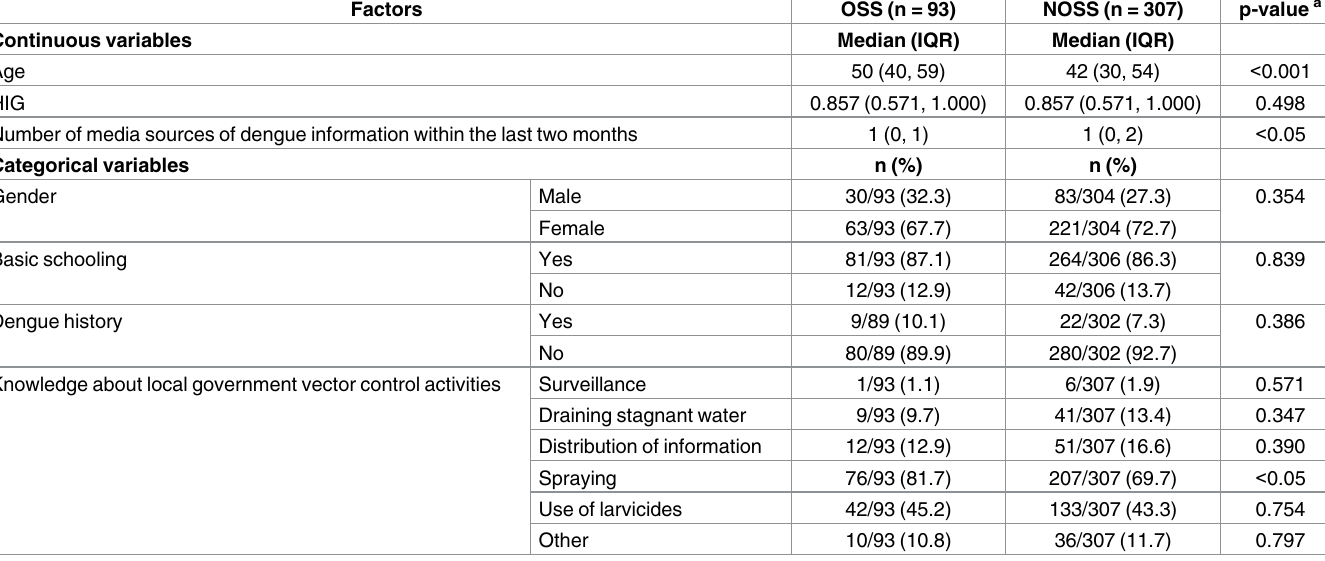
Table 2. Residents profile by OSS